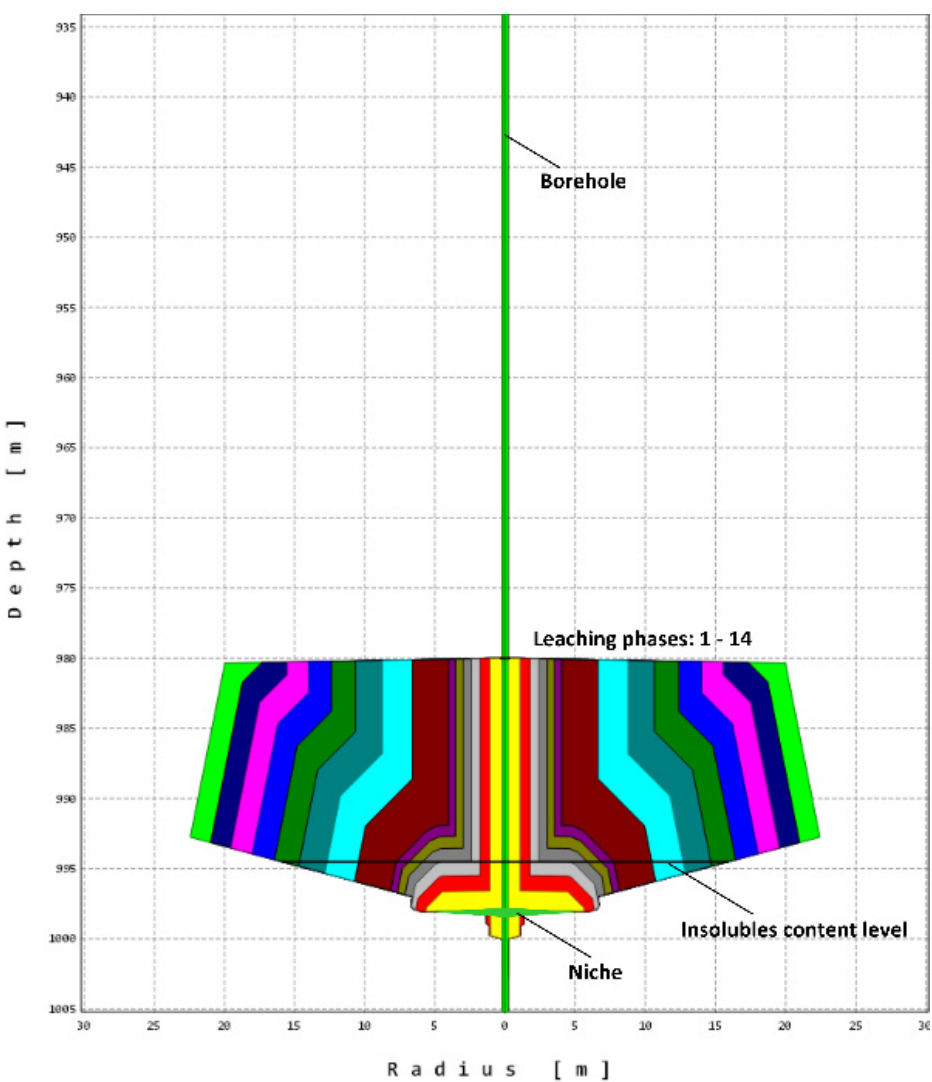
Figure 5. Sump shape after the end of the leaching for scenario 2—1 niche (S I/S 2—1 niche).